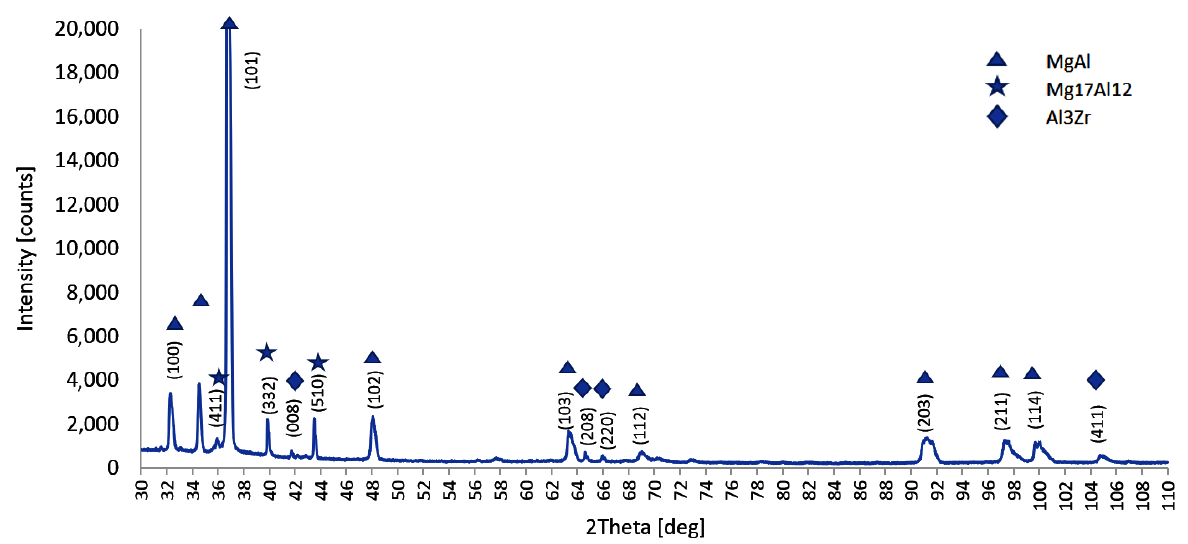
Figure 7. Microstructure of AZ91 with 0.3 wt % of Zr alloy during a SEM analysis ( a ), microstructure of α Mg including a phase containing zirconium ( b ), and chemical composition spectrum of the analysed phase ( c ).